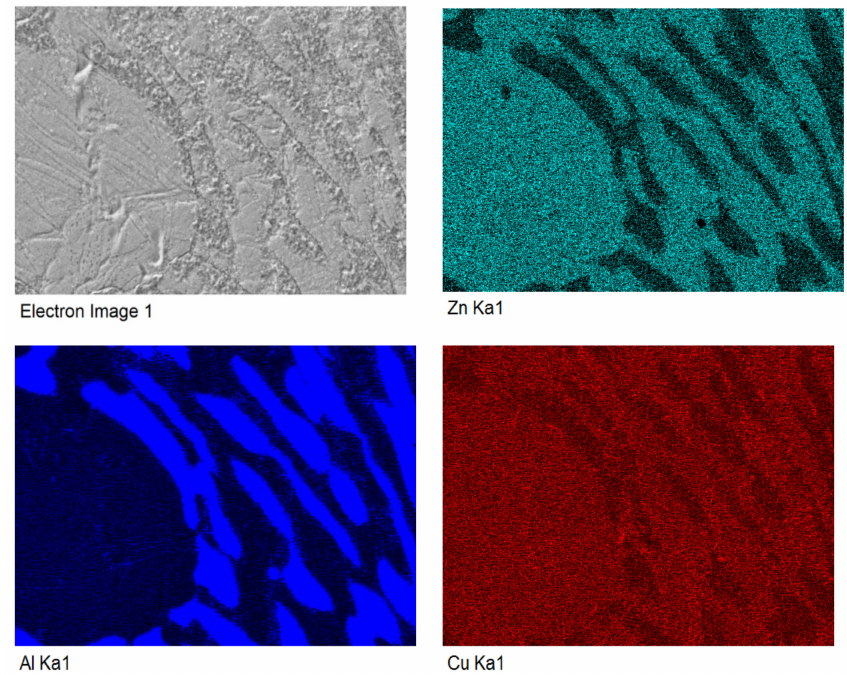
Figure 10. Map of Zn, Al, and Cu elements in the structure of Zn5Al3Cu